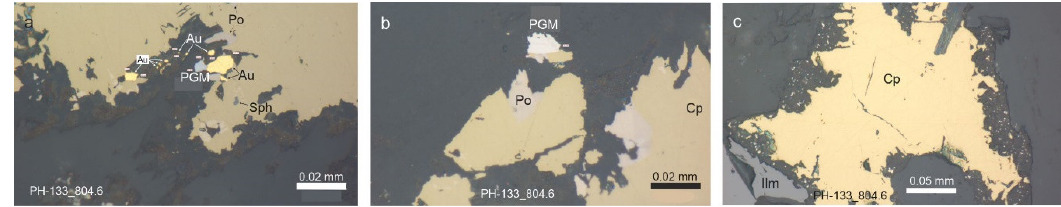
Figure 6. Microparageneses of the minerals in the taxite gabbro-dolerite: ( a , b ) chalcopyrite in intergrowth with pyrrhotite (Po), gold (Au) and minerals of platinum group elements (PGM); ( c ) chalcopyrite in intergrowth with ilmenite (Ilm).